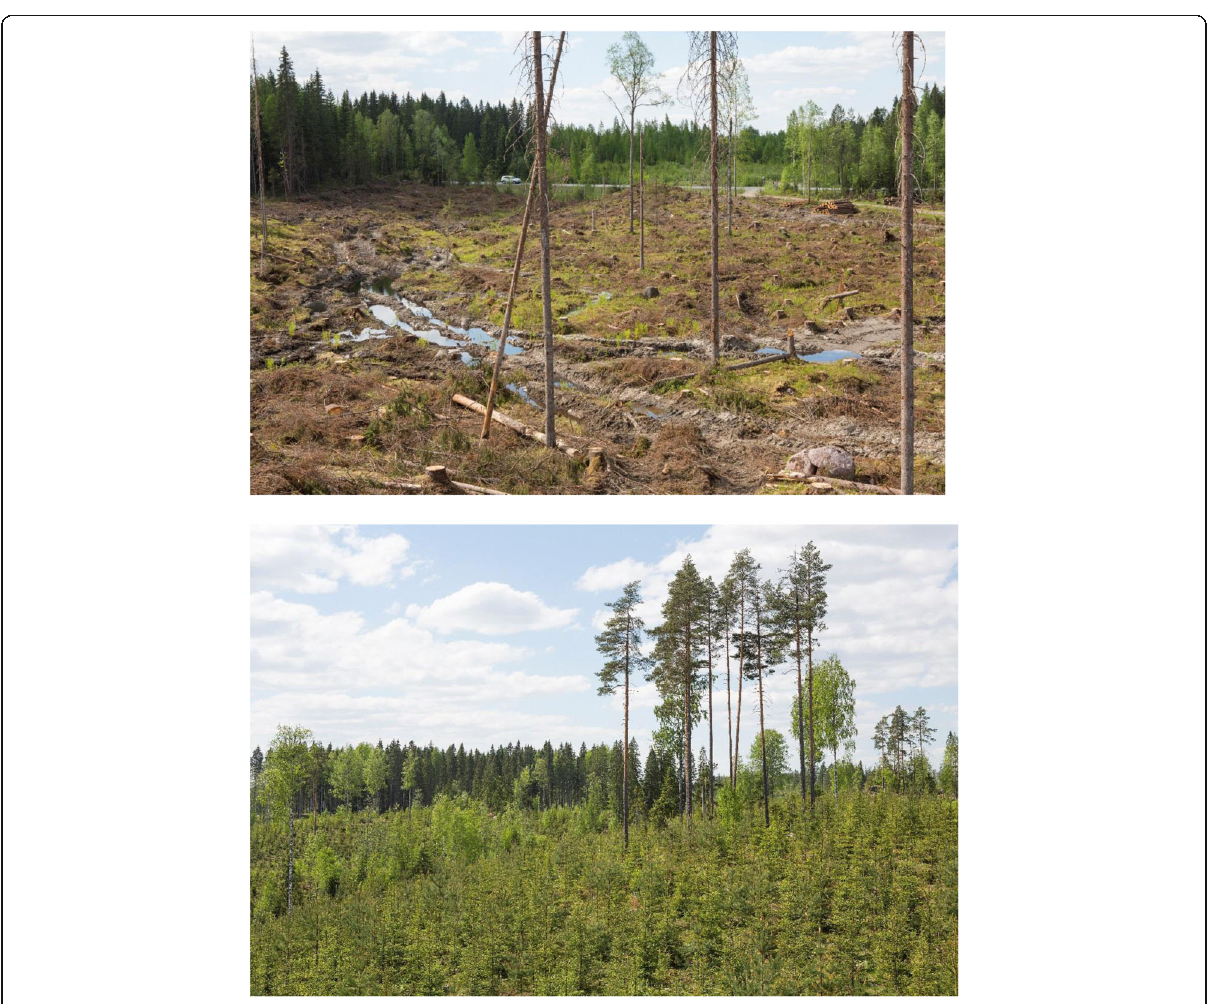
Fig. 1 Above: a typical small fresh clearcut with some retention trees in Finland after harvesting. Below: a regenerated clearcut with retention- tree groups in Finland. Photos: Erkki